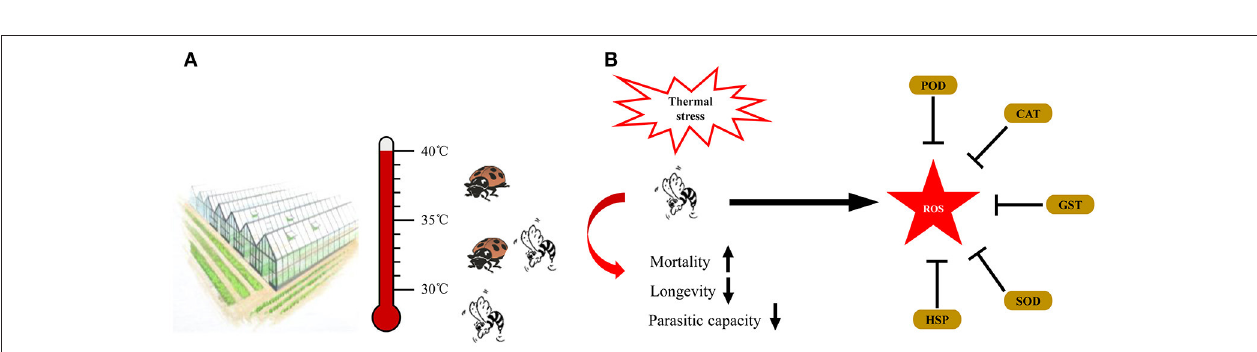
FIGURE 5 | Antioxidative enzyme activities of A. gifuensis adults after different levels of heat stress for 1h. The temperature of 25 ◦ C severed as a control. Each value represents the mean ( ± SE) of five replications. Different letters over the bars designate a significant difference at P < 0.05. And “*” means P < 0.05, “**” means P < 0.01, “***” means P < 0.001.